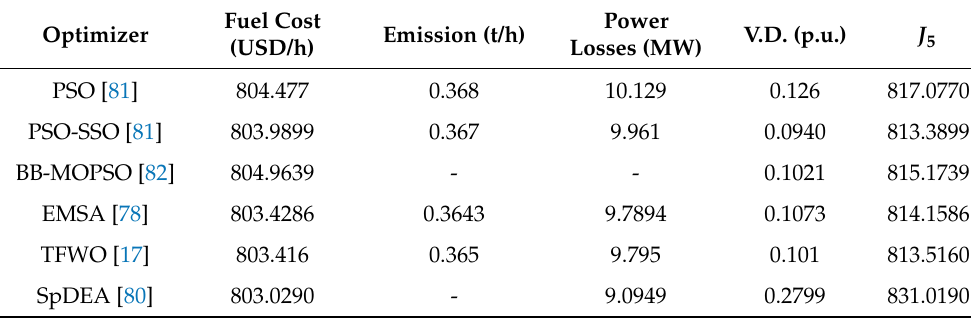
Table 8. Optimal results of the present study in Case